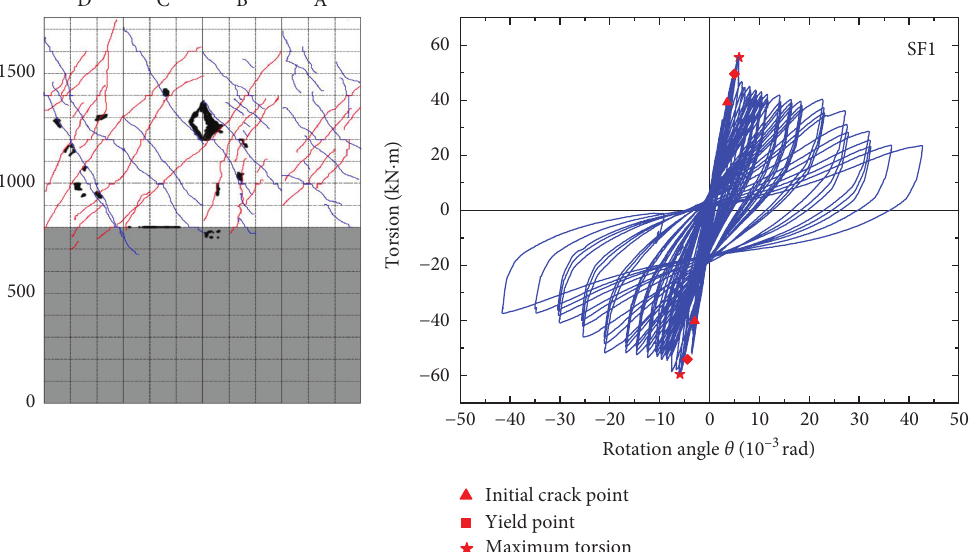
Figure 10: Damage and hysteresis curves of specimen SF1.